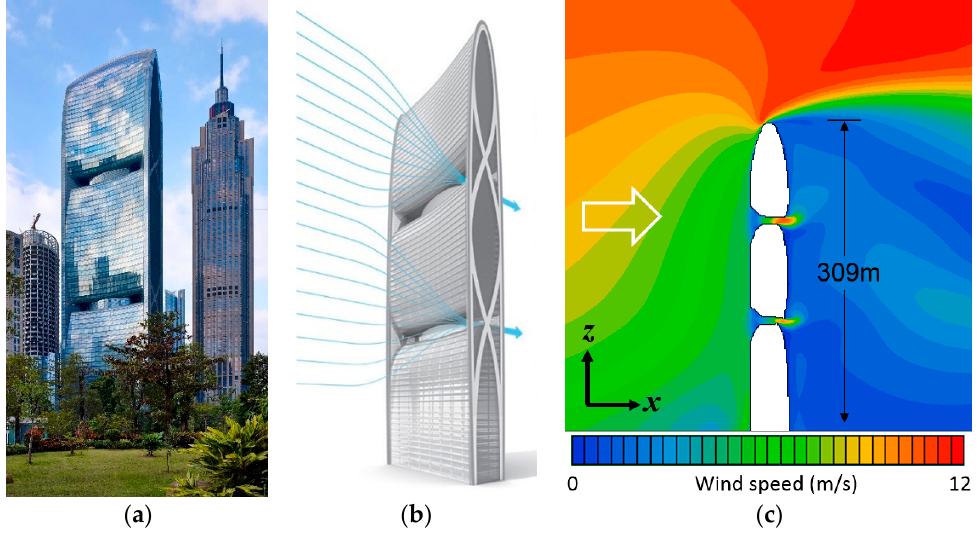
Figure 3. The Pearl River Tower: ( a ) photo of front view; ( b ) wind penetration structure; and ( c ) contour plot of wind speed on a horizontal cross-sectional plane (CFD by the authors).